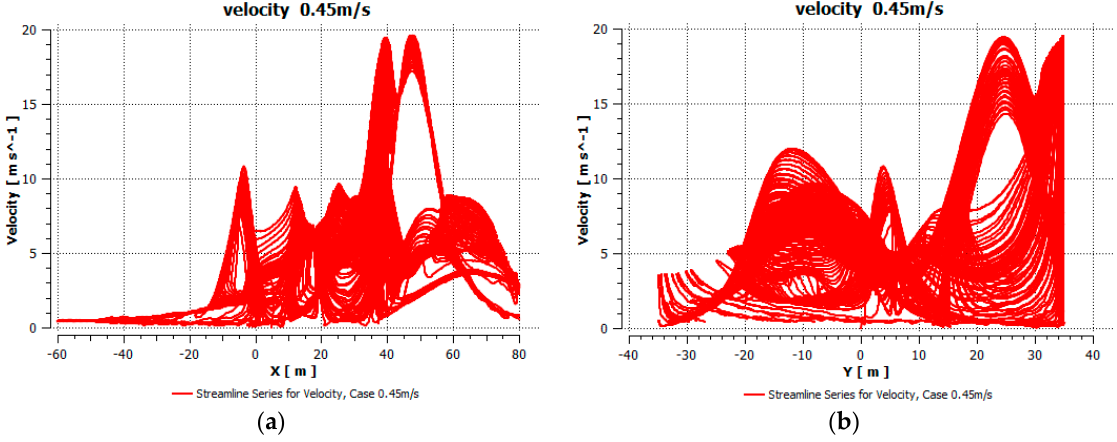
Figure 19. Wall shear contour for the flow on the free-floating buoy under 1.5m/s case.